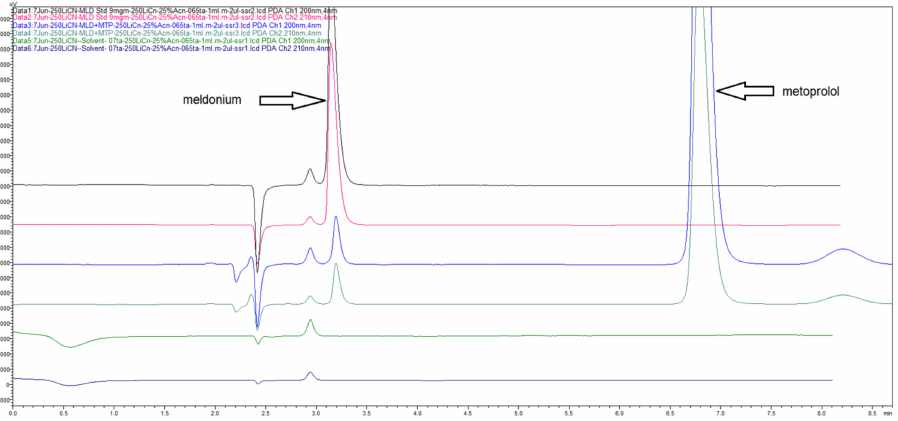
Figure 11. Chromatograms confirming the selectivity of 250 × 4 mm LiChrospher CN column when 25% ACN with 75% diluted 0.065% v / v TFA was used at mobile phase, simultaneously compared at 2 wavelengths 200 nm and 210